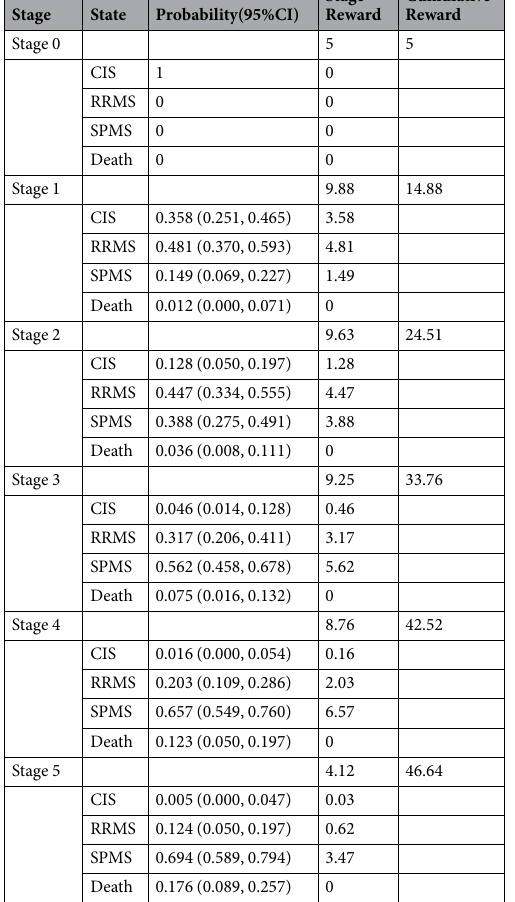
Table 3. Transition probabilities and life expectancy of patients with CIS. CIS: clinically isolated syndrome; RRMS: relapsing-remitting multiple sclerosis; SPMS: secondary progressive multiple sclerosis. Stage: cycle period, each cycle period refers to 10 years; e.g., “Stage 0” refers to the period before the first cycle, and “Stage 1” refers to the first cycle. State: disease state. Probability: transition probability at each stage. Stage reward: life expectancy at each stage. Cumulative reward: cumulative life expectancy at each